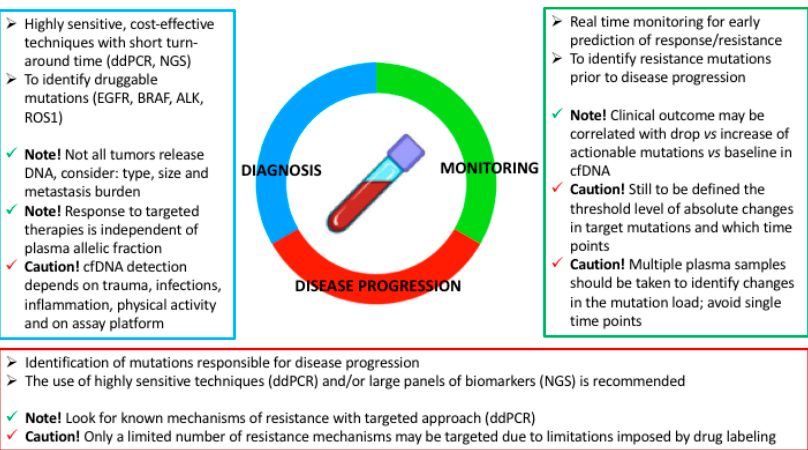
Figure 2. The use of liquid biopsy and circulating cell-free DNA (cfDNA) in clinical practice to guide the choice of treatment strategy. Digital droplet PCR (ddPCR), next generation sequencing (NGS), Epidermal Growth factor Receptor (EGFR), Anaplastic Lymphoma Kinase (ALK), avian UR2 sarcoma virus oncogene homolog 1 ROS1.